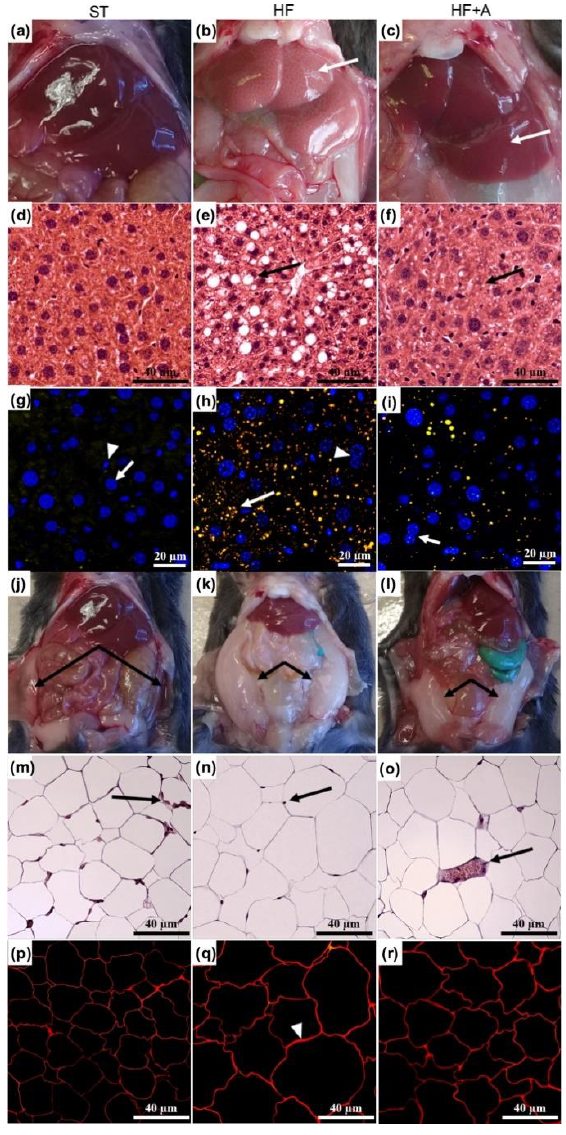
Figure 4. Agavins supplementation reduced hepatic steatosis and lipid droplets content as well as the amount of adipose tissue and adipocyte size in mice fed high-fat diet. ( a – c ) Representative images of liver after consumption of the different diets; ( d – f ) Histopathological examination of mouse livers by hematoxylin and eosin staining; ( g – i ) Accumulation of lipid droplets in the mouse livers. Lipid droplets were stained with red Nile (yellow) and nucleus with DAPI (blue); and analyzed using a multiphoton microscope system. ( j – l ) Representative images of adipose tissue present in the mice after the intake of the different diets; ( m – o ) Histopathological examination of adipocyte size using hematoxylin and eosin staining; ( p – r ) Adipocytes stained with red Nile. HF (mice fed with a high-fat diet); HF+A (mice fed with a high-fat diet plus agavins); ST (mice fed with a standard diet).